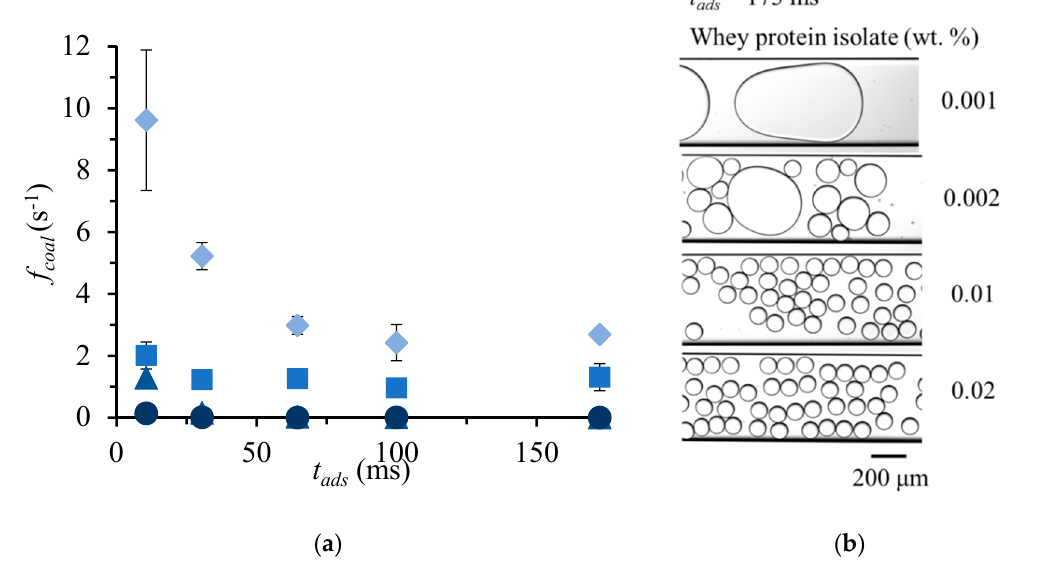
Figure 13. ( a ) Mean coalescence frequency and microscope images from the outlet of the collision channel with 0.001 ( ♦ ), 0.002 ( ■ ), 0.01 ( ▲ ), and 0.02 ( ● ) wt % whey protein isolate. The error bars indicate the standard deviation of the three recordings taken per measurement [86]. ( b ) Images taken at difference protein concentrations for an adsorption time of 173 milliseconds. Reprinted with permission form Elsevier.